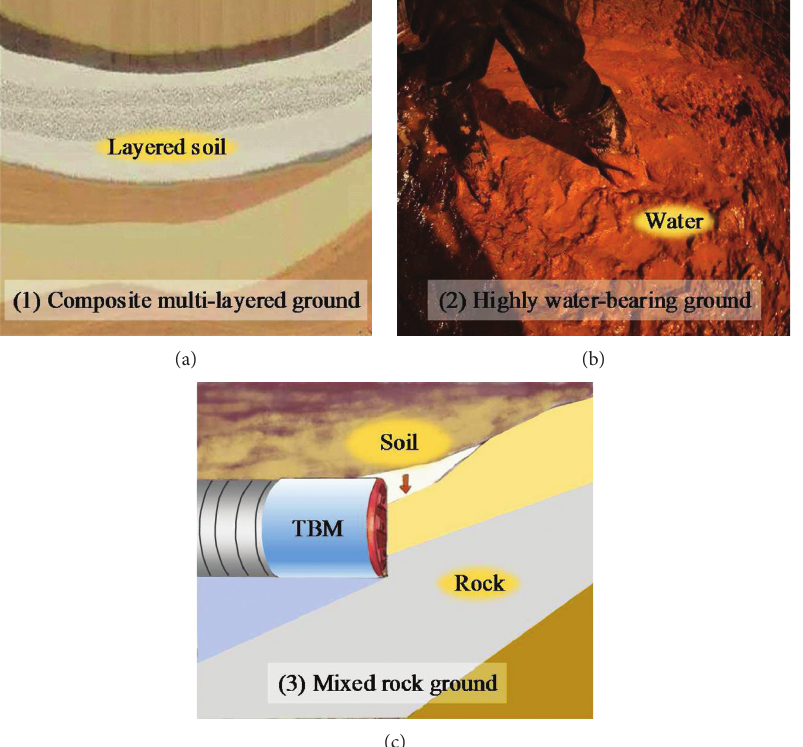
Figure 1: Three typical types of urban ground in China. (a) Composite multilayered ground, (b) highly water-bearing ground, and (c) mixed rock